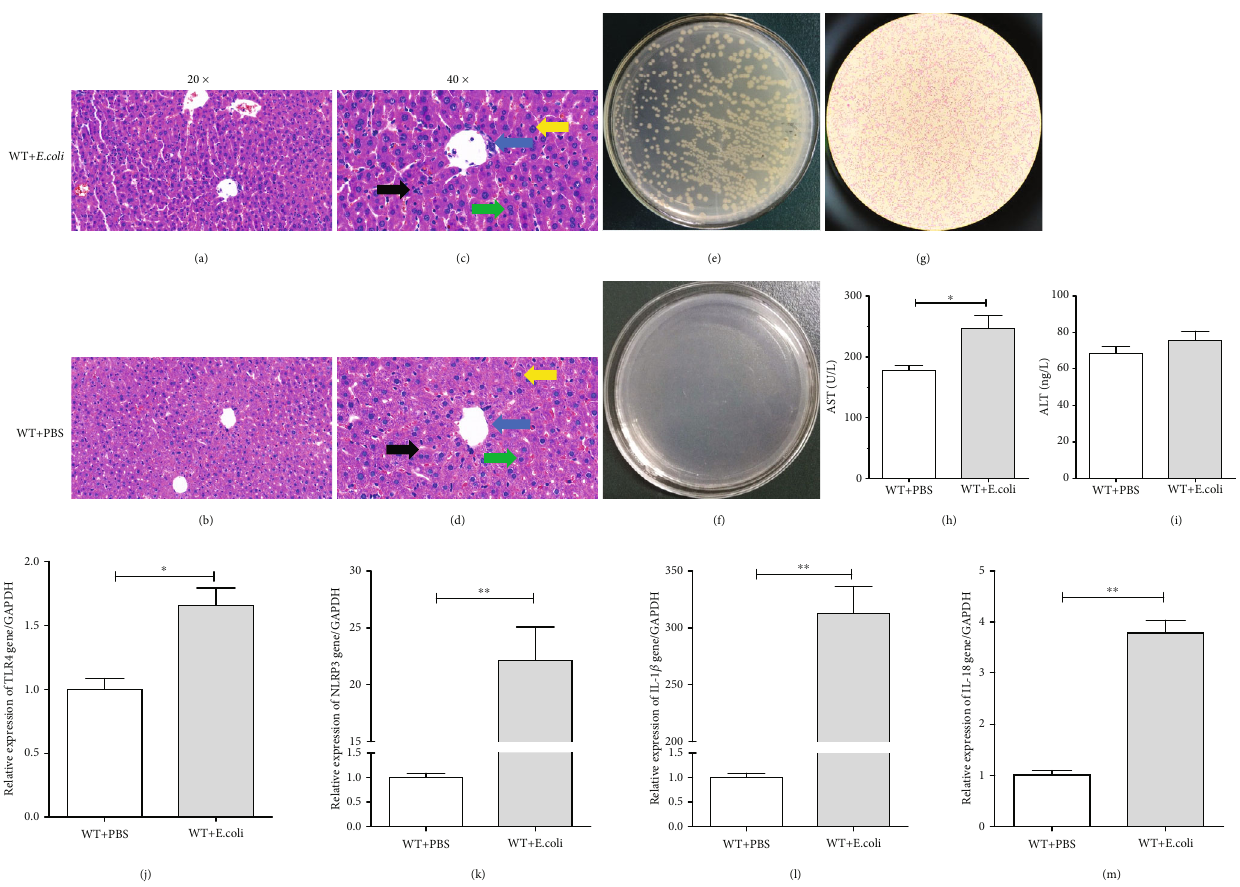
Figure 1: Escherichia coli can induce liver injury in mice. WT mice were injected with PBS or 3 × 10 8 cfu/ml E. coli intraperitoneally and sacri fi ced 3 hours later. Liver pathological injuries were observed with hematoxylin and eosin staining (a – d). The yellow arrows indicate edema, the blue arrows indicate in fl ammatory cell in fi ltration, the black arrows indicate punctate necrosis, and the green arrows indicate binucleate hepatocytes. Bacteria from the liver of PBS- or E. coli -stimulated WT mice were cultured in MH medium (e, f) overnight and identi fi ed by Gram staining (g). The serum AST (h) and ALT (i) concentrations were determined by using the detection kits. The mRNA of liver in fl ammatory cytokines TLR4 (j), NLRP3 (k), IL-1 β (l), and IL-18 (m) of PBS- or 3 × 10 8 cfu/ml E. coli -stimulated mice were measured by RT-qPCR. Data are presented as means ± standard deviation . Statistical signi fi cance was determined by the paired t -test ( n = 3 , ∗ p < 0 : 05 , ∗∗ p < 0 : 01